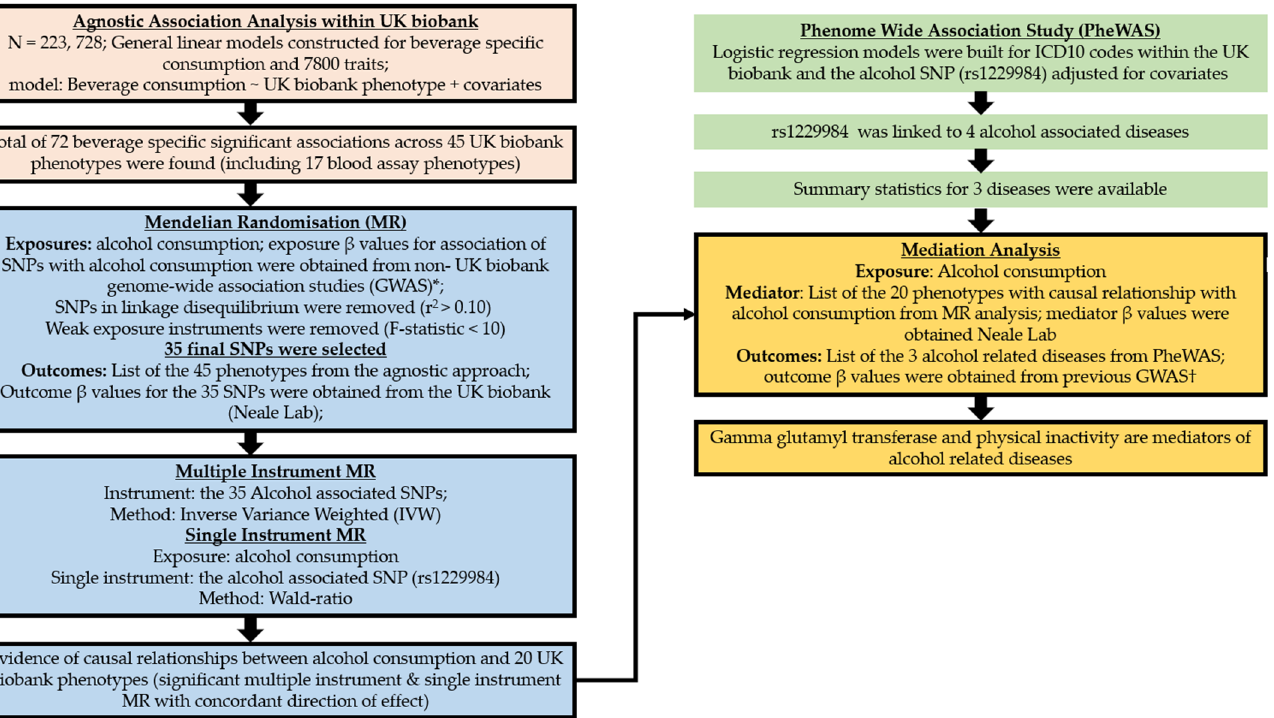
Figure 2. Overview of the study design. * Beta values for exposure were obtained from the non- UK biobank part of the summary statistics provided by Liu and colleagues (multiple instrument MR) [15] and Jorgenson and colleagues (single instrument MR) [16]. † In the mediation analysis, outcome beta values were obtained from Olfson and colleagues [17] and Butch and colleagues [18]. SNP, single nucleotide polymorphism.